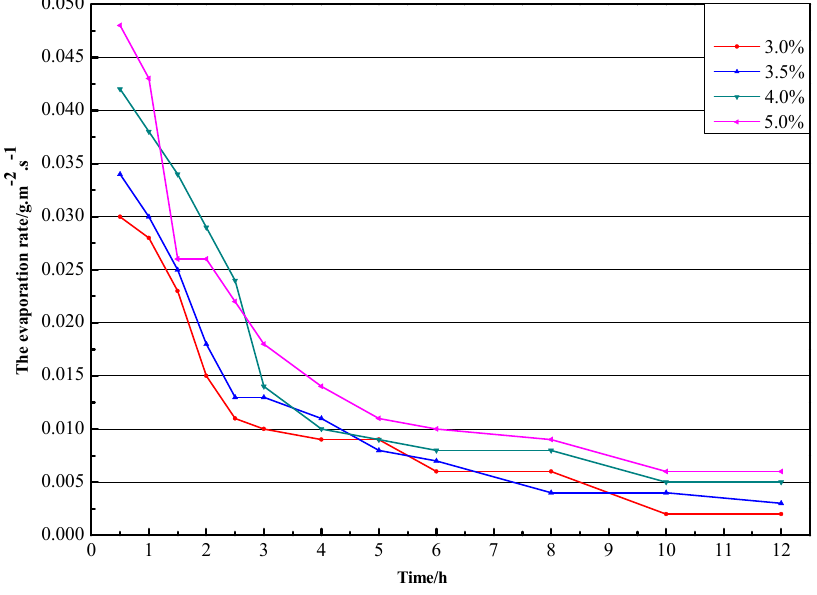
Figure 3. Trend chart of sample evaporation rate with time (concentration 3%, 3.5%, 4%, 5%).